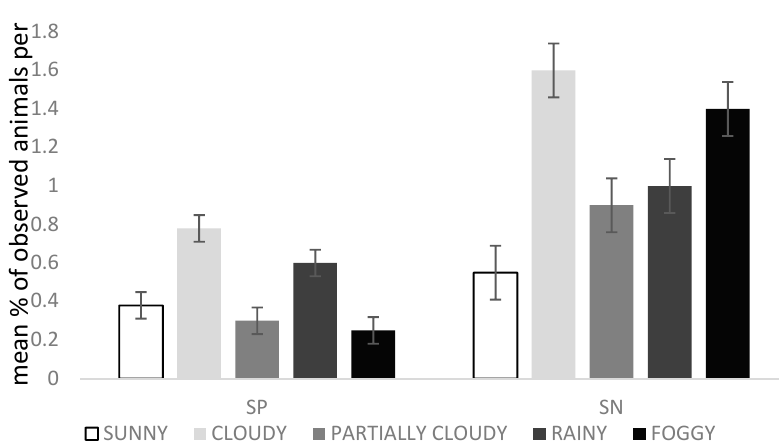
Figure 2. Mean % of observed animals per scan ± SEM of the social positive (SP) and social negative (SN) behaviours during the different weather conditions (sunny, cloudy, partly cloudy, rainy and foggy) in relation to a total of 1439 observations. Analysed with general models of SAS (Poisson or negative binomial distribution).